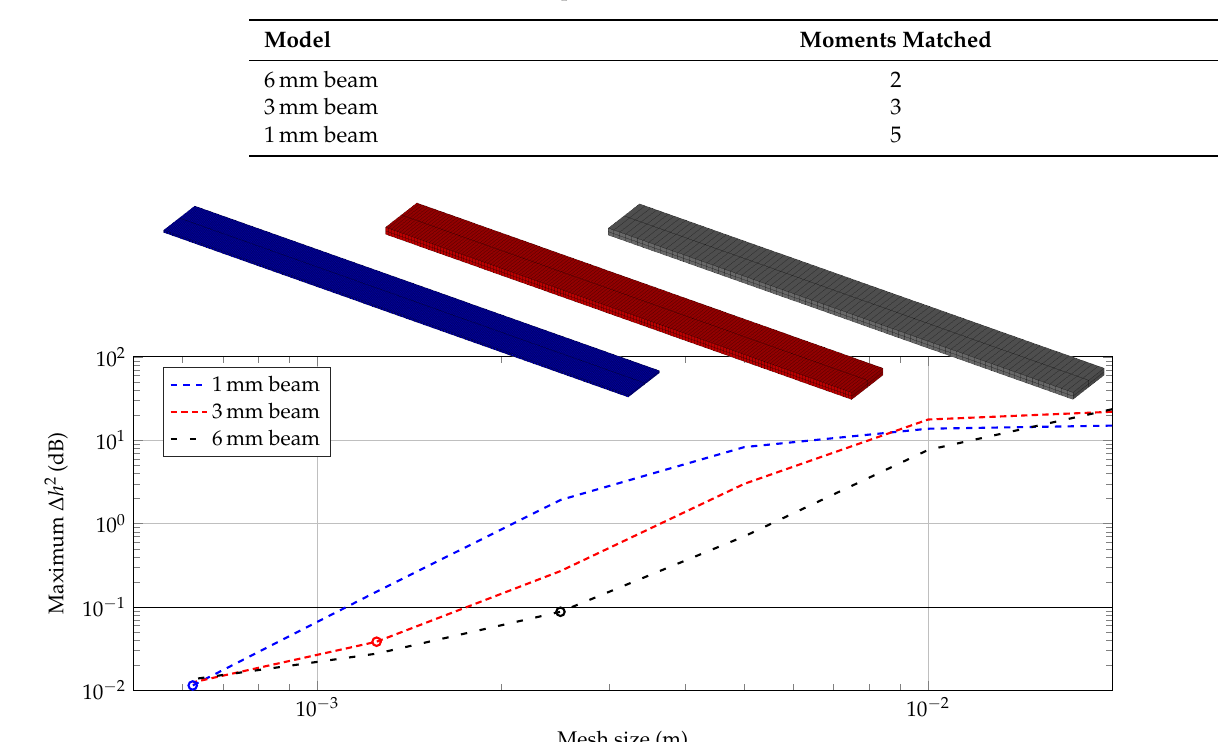
Table 5. Number of matched moments in the reduced-order model (ROM) in order to ensure a